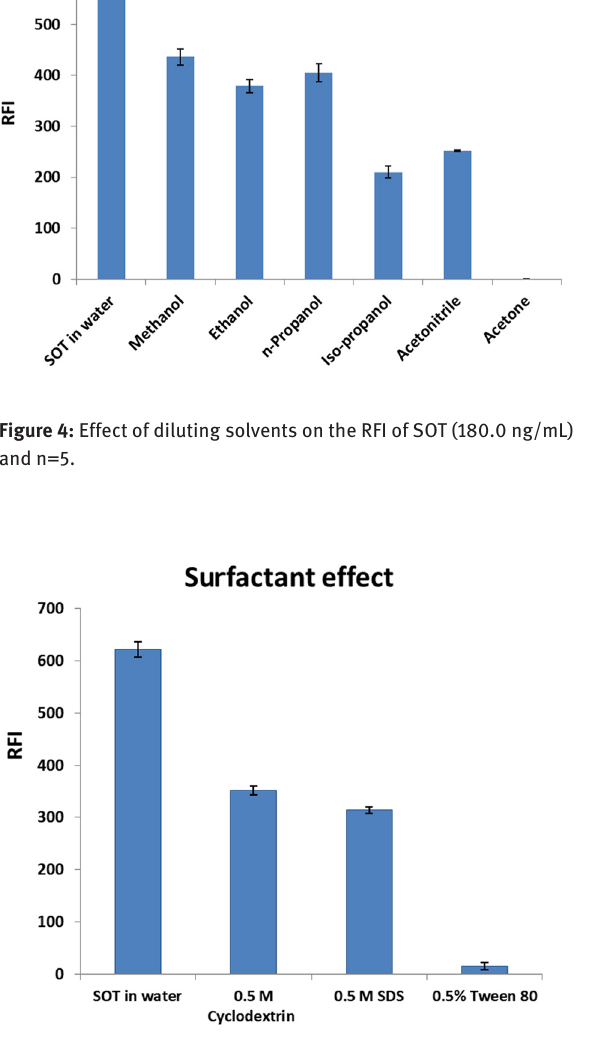
Table 1: Analytical performance data for the determination of SOT by the proposed